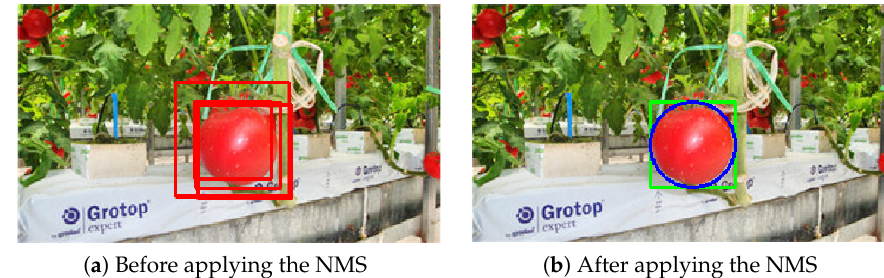
Figure 14. An example of the NMS: ( a ) before and ( b ) after applying the NMS.